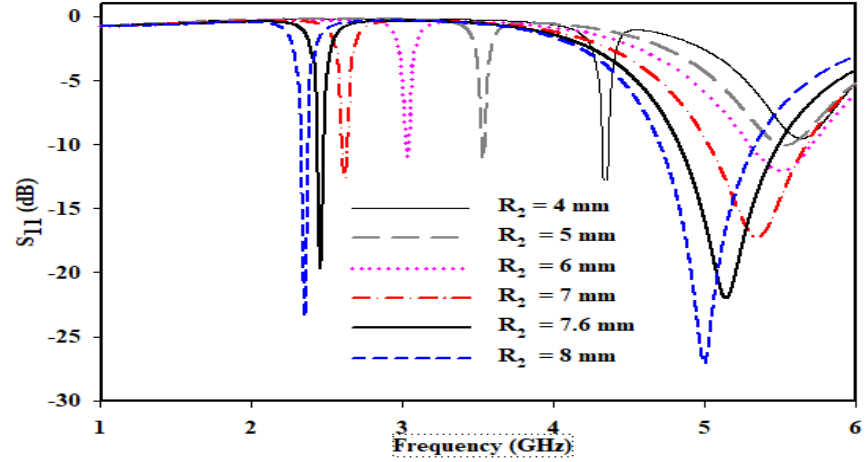
Figure 9. Variation in resonant frequency with respect to radius of CDNG-MTM.